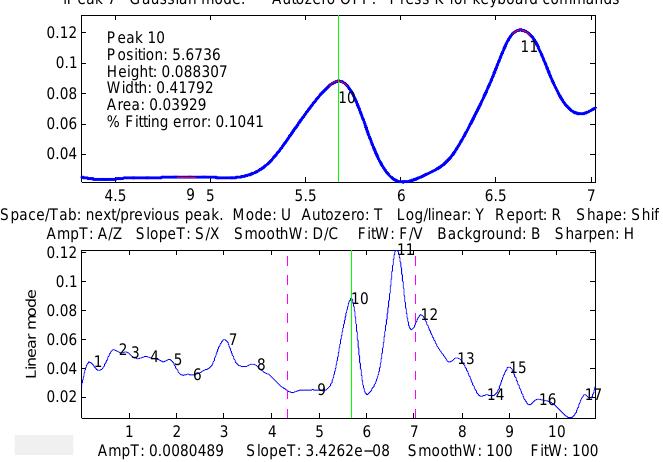
Figure 5. Finding peaks in the filtered EMG signal. Interface window of the ipeak function: entire pre-processed signal ( Bottom ) with 17 peaks detected and the zoomed-in portion of the signal ( Top ) containing the two highest peaks (# 10 and # 11). Note: the position is in seconds on the X (horizontal)